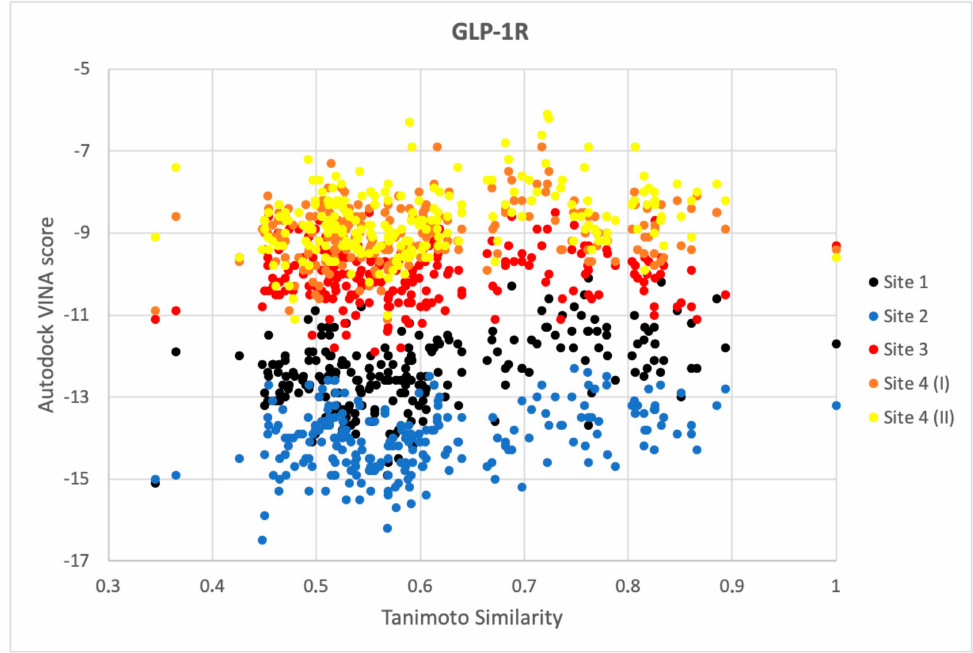
Figure 3. Results for GLP-1R compounds similar to the binding site 1 ligand. The lower binding energy (Autodock VINA score), the better fitness between the ligand and the type of the receptor binding site. Here, sites 1–4 notation corresponds to the notation presented in Figure 1. Site 4 (I) corresponds to the binding site of NAM in 6LN2, site 4 (II)—to the binding site of NAM in